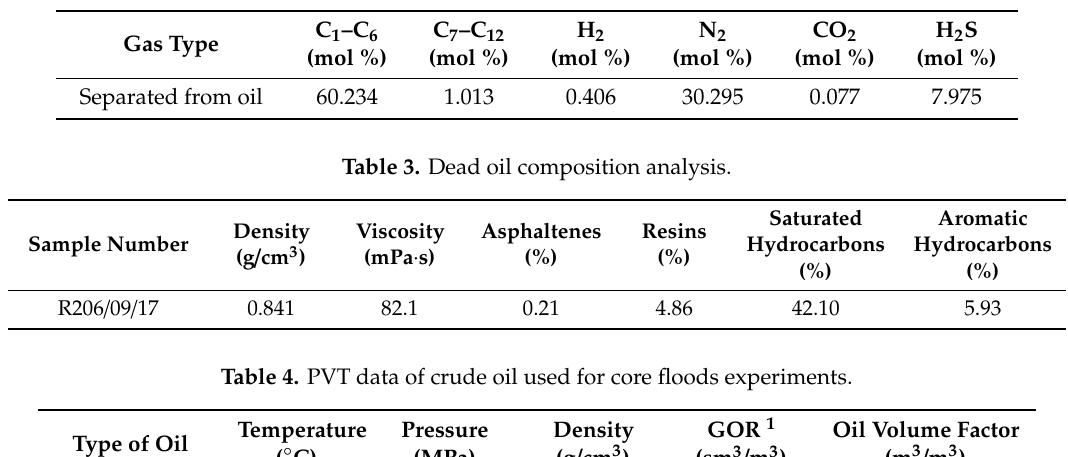
Table 2. Gas analysis: main components.